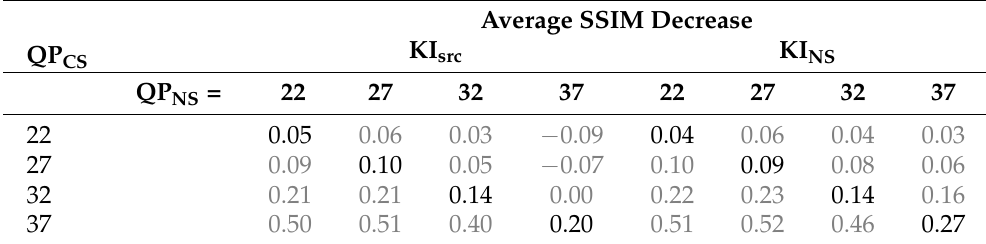
Table 5. Average decrease in Structural SIMilarity